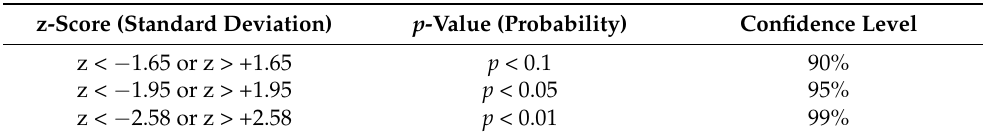
Table 4. Critical p -value and z-score with various confidence levels. z-Score (Standard Deviation) p -Value (Probability) Confidence